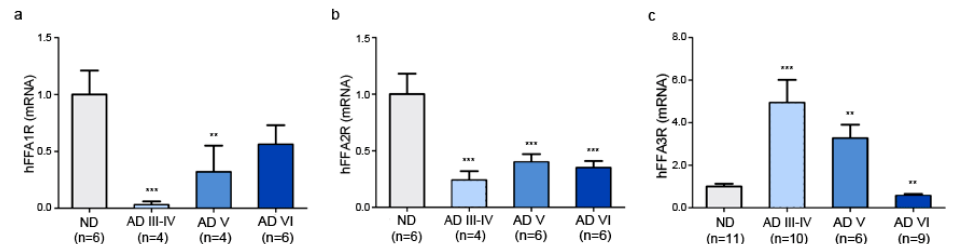
Figure 1. FFARs in postmortem hippocampus tissue from AD patients. mRNA levels of FFAR in hippocampal sections of AD patients and the corresponding ND controls analyzed by RT-qPCR. Bars represent the receptor mRNA expression normalized to that of the corresponding 36B4 internal control. Values are expressed as mean ± SEM. ( a ) Expression levels of FFA1R in ND and patients of different stages of AD. ( b ) Expression levels of FFA2R in ND and patients of different stages of AD. ( c ) Expression levels of FFA3R in ND and patients of different stages of AD. ** p < 0.01, *** p < 0.001 vs.